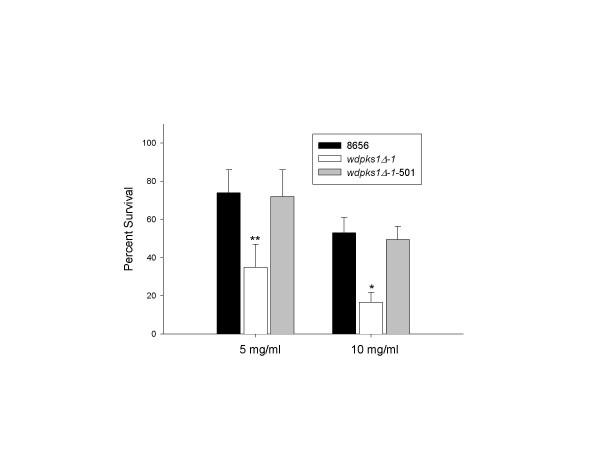
Survival of W. dermatitidis yeast cells in the presence of lysing enzymes. Strain 8656, wdpks1Δ-1, and wdpks1Δ-1-501 yeast cells grown for 7 days in YPD medium at 37°C and incubated in different concentration of Sigma lysing enzymes. Survival was compared to fungal cells incubated in PBS. The melanin-deficient mutant was significantly more susceptible to killing by incubation in lysing enzymes. Values are of the standard errors of the means for three measurements. *, p < 0.001 and **, p < 0.01. The experiment was repeated with similar results.